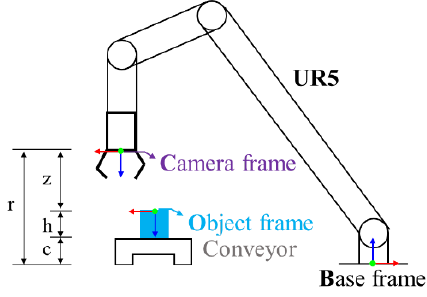
Figure 26. Parameters of heights for different frames in the system.